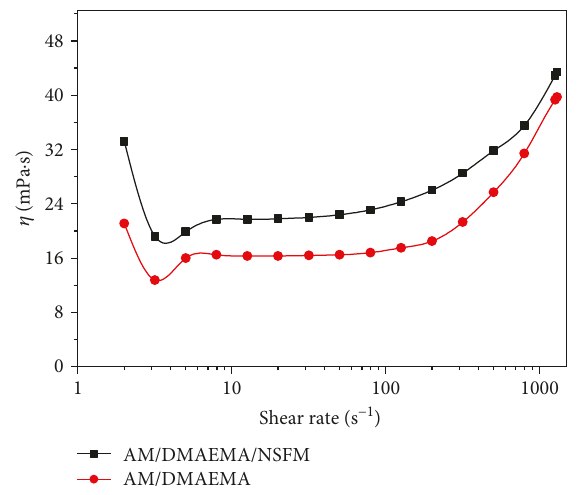
Figure 6: E ff ect of shear rate on the viscosities of AM/DMAEMA and AM/DMAEMA/NSFM solutions. The copolymer solutions (0.2 wt%) were prepared in distilled